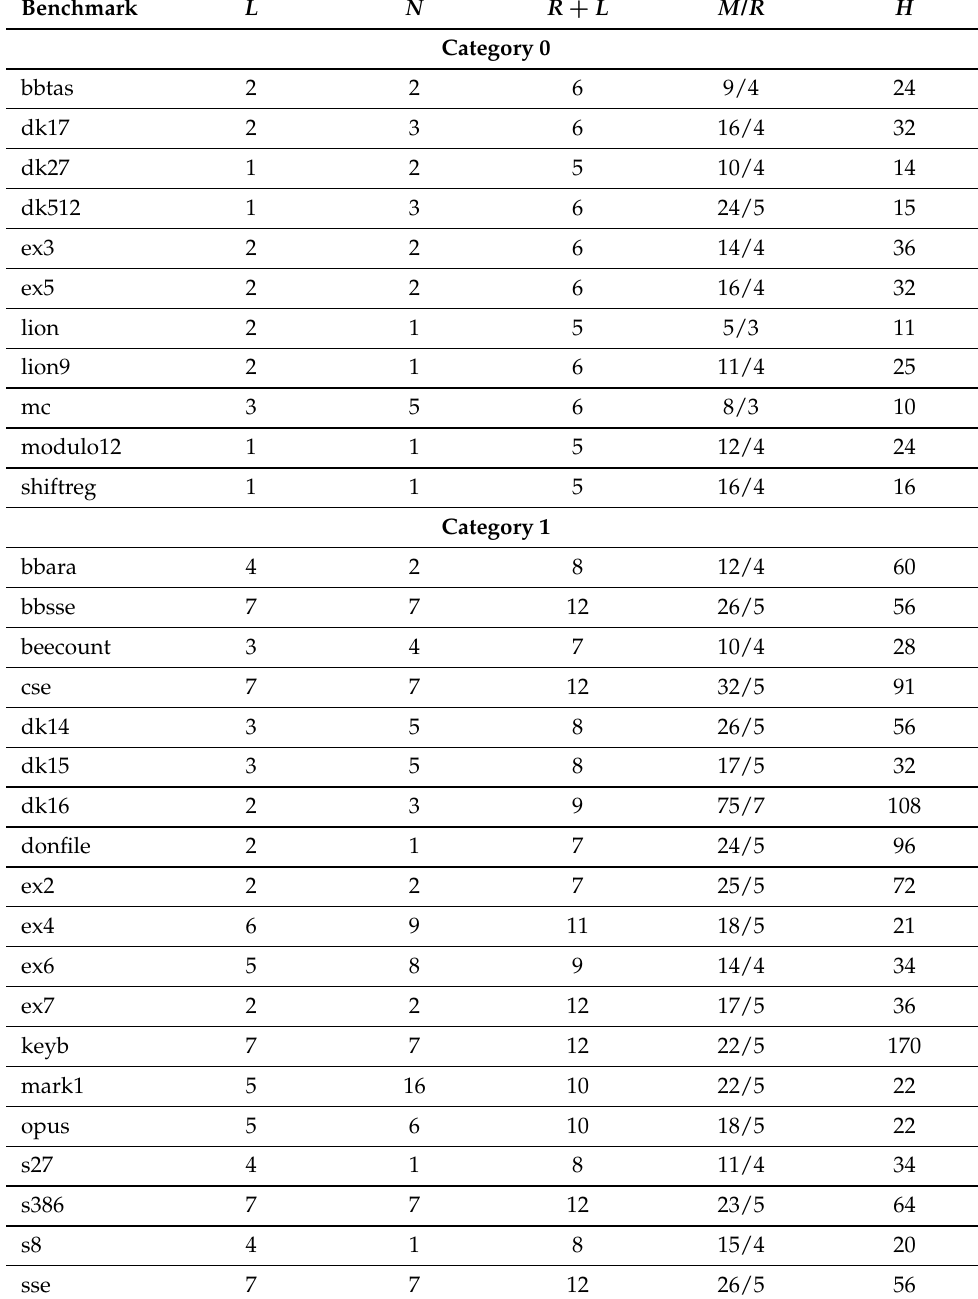
Table 10. Characteristics of Mealy FSM